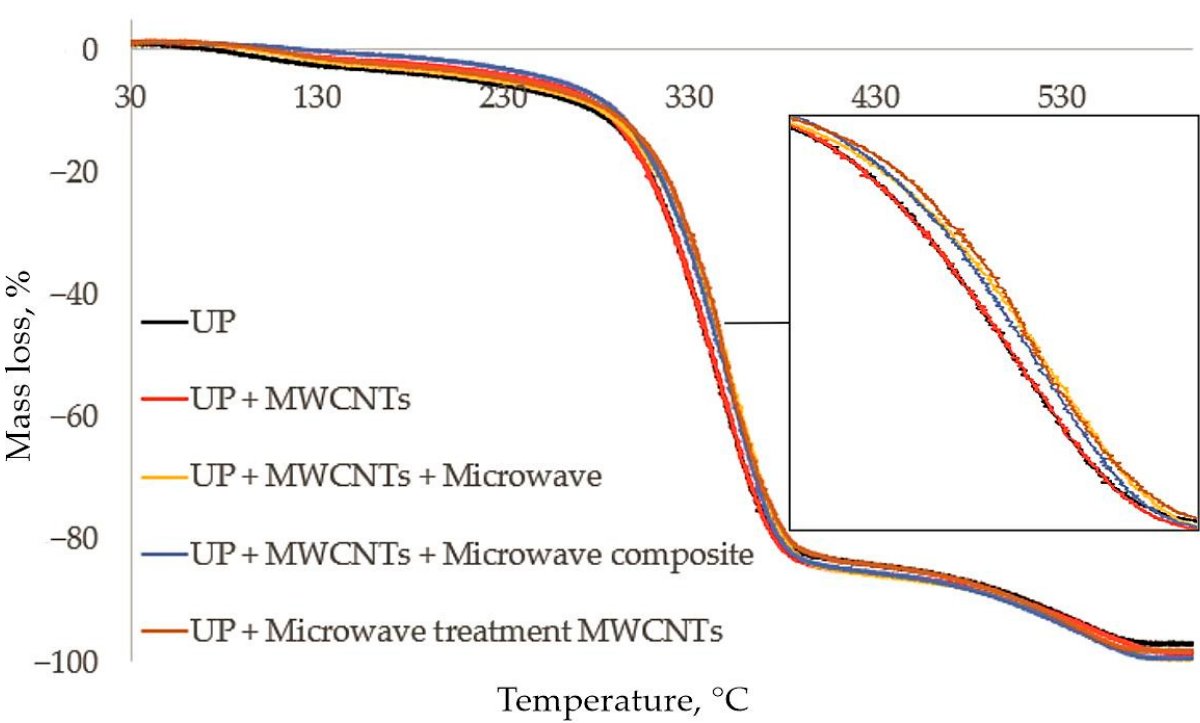
Figure 8. Data of thermogravimetric analysis polyester samples. Table 4. Thermogravimetric analysis results.